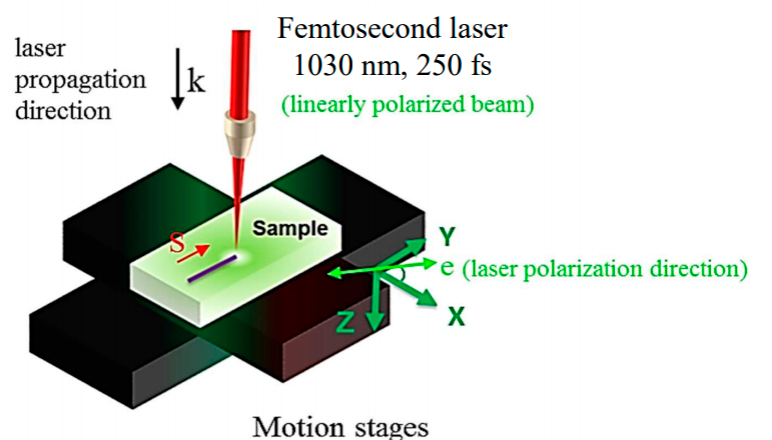
Figure 3. Experimental laser setup, and convention for the reference on the sample and its relation to the reference on the laser. S and e correspond to the scanning direction and the polarization direction, respectively. Note: in this work, Yy configuration corresponds to e parallel to S (e is along Y), and Yx configuration to e perpendicular to S (e is along X).